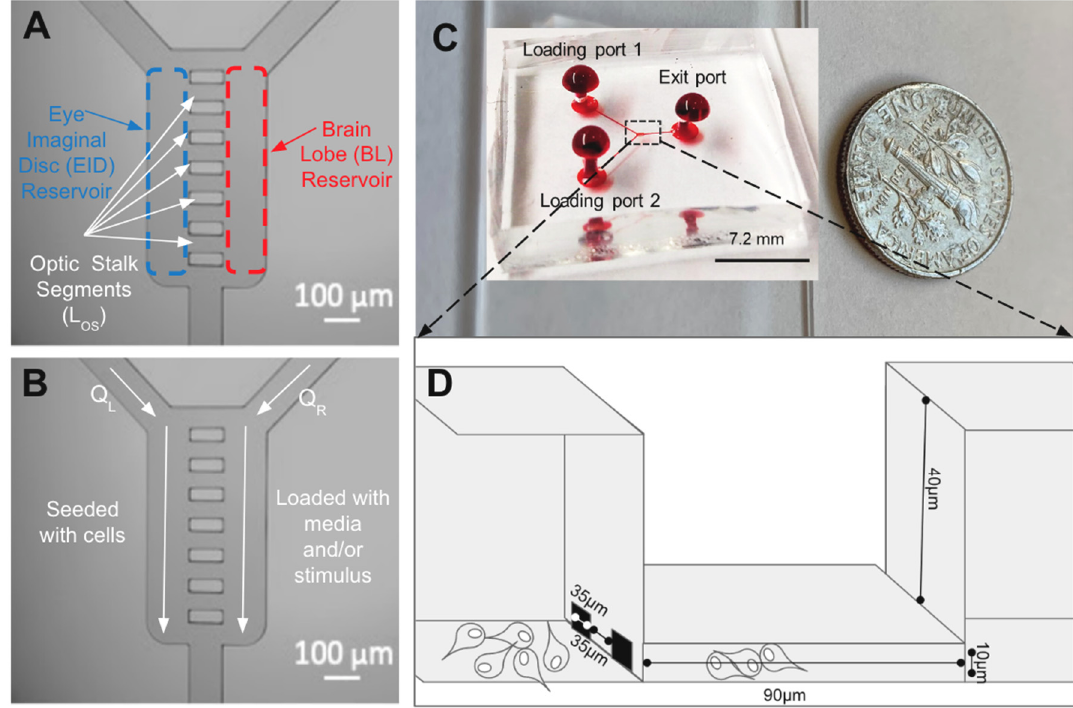
Figure 2. The micro-optic stalk ( µ OS) system is designed to represent cellular paths of retinal neuroblasts (RNBs) between the eye imaginal disk and brain lobe of the developing visual system of Drosophila Melanogaster. ( A ) Schematic of the system illustrating an array of eight horizontal microchannels (L OS ) connected to two vertical fluidic reservoirs to represent the eye imaginal disc (EID) and brain lobe (BL). ( B ). During loading, RNBs are seeded in the EID reservoir (left) at a volume flow rate of Q L , while a solution of media and / or growth factor stimulus is flushed in the BL reservoir (right) at a volume flow rate of Q R . During testing, solutions are continually flushed in the EID and BL, while the migration or RNBs within L OS segments is imaged each hour. ( C ) Image of the polydimethylsiloxane (PDMS) elastomer bonded onto a glass coverslip and with red dye to facilitate system visualization. Loading ports 1 and 2 and the Exit port are labeled alongside a dime for overall system scaling. The dashed lines indicate the region of interest. ( D ) Schematic cross-section of the µ OS system after cell seeding. RNBs are seeded in the EID reservoir (left) and migrate through the OS microchannels in response to growth factor stimulus within the BL reservoir (right).